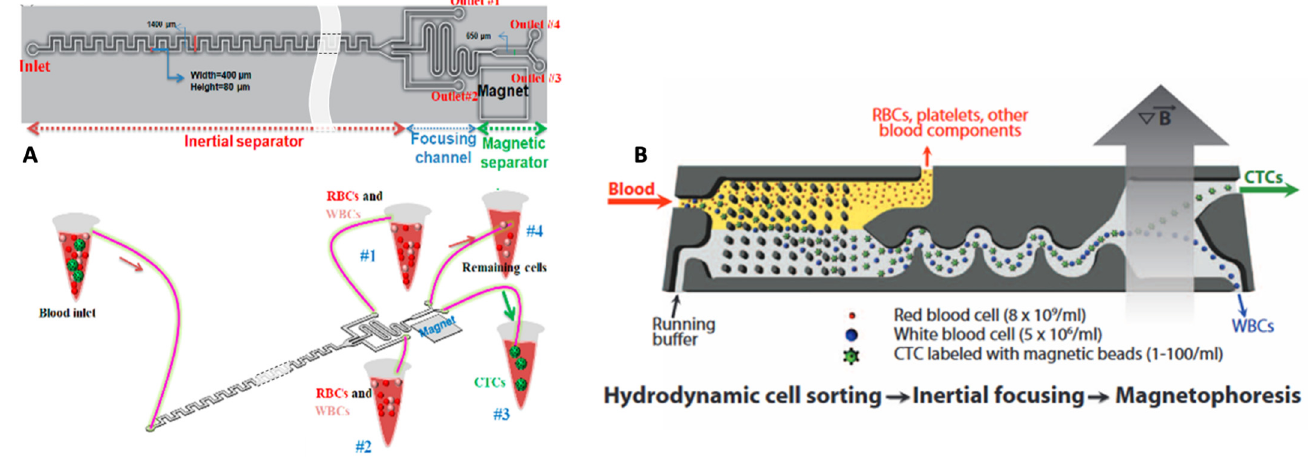
Figure 15. Magnetophoretic separation devices combined with passive hydrodynamic functions for CTCs isolation ( A ) Inertial (not at scale) and magnetophoretic combined separators [197] ( B ) Hydrodynamic cell sorting (deterministic lateral displacement) and inertial focusing combined with magnetophoretic sorting. Reprinted from [198] with permission from AAAS.